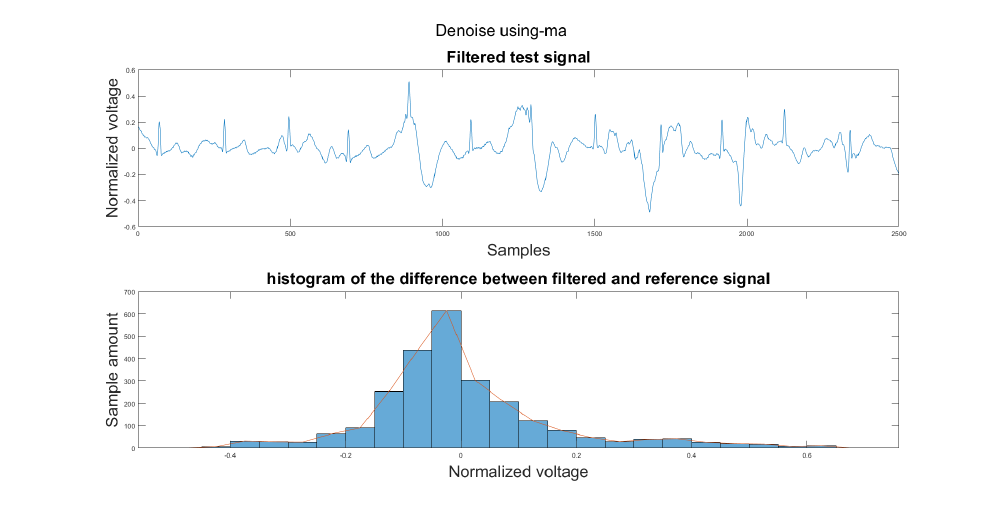
Figure A16. (1) Test signal, (2) histogram of the difference.